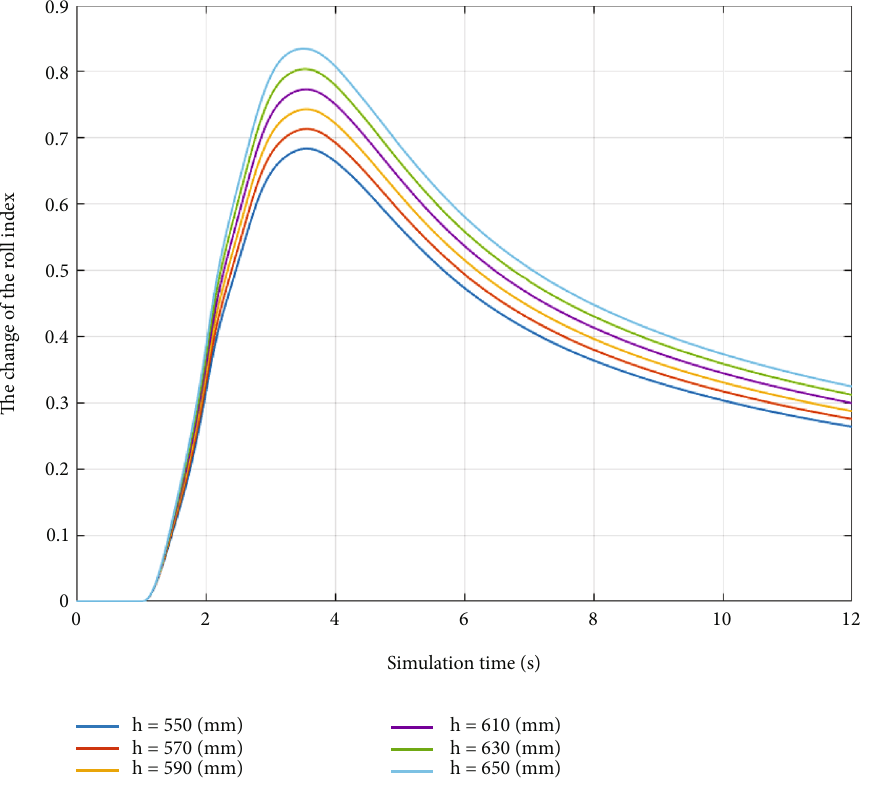
Figure 11: The change of the roll index (the second case — distance change).